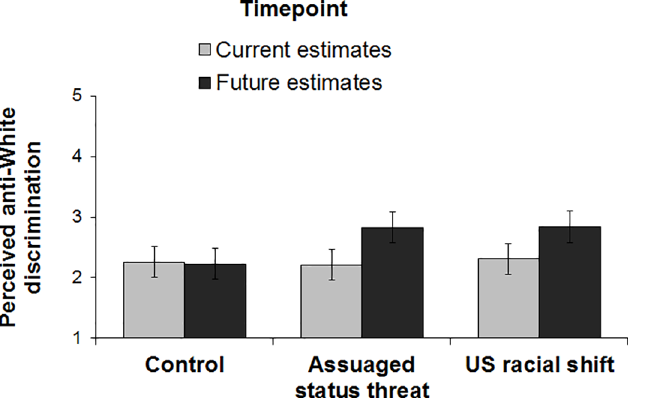
Fig 2. Perceived anti-White discrimination by experimental condition and timepoint (Study 2). Error bars represent within-subjects 95% confidenceintervals[27].